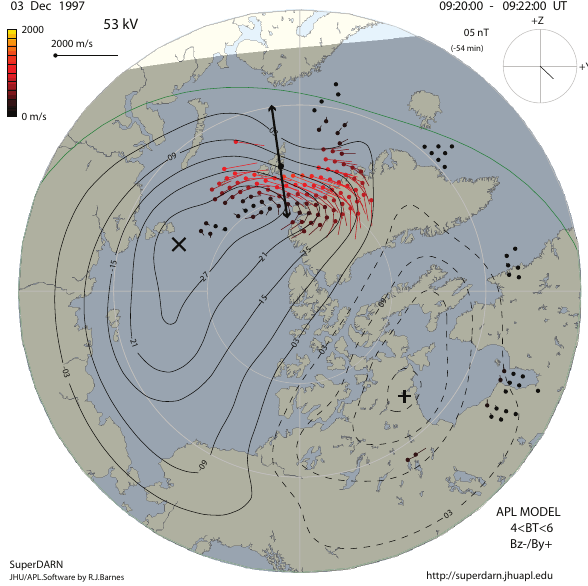
Fig. 10. SuperDARN convection data for 09:20–09:22UT. Same format as in Fig.